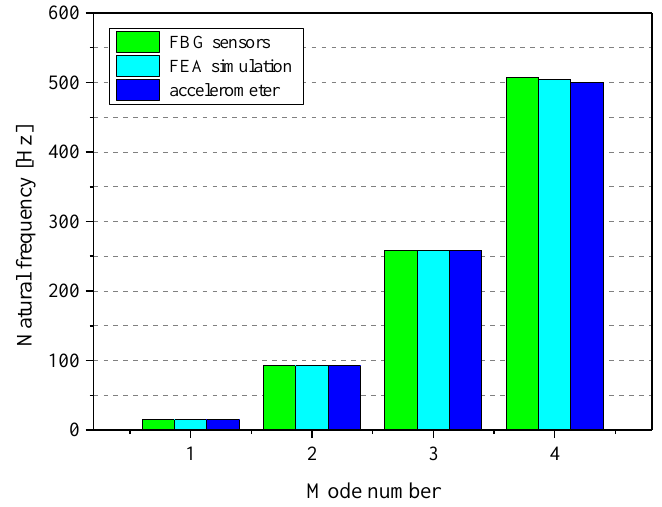
Figure 6. Comparison of experimental and analysis natural frequencies.